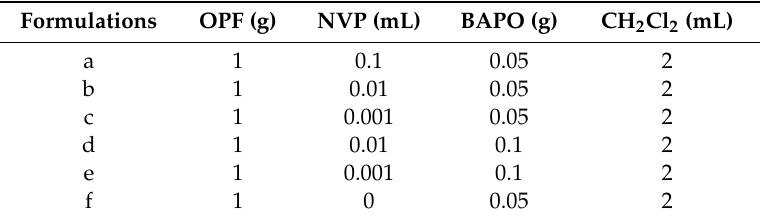
Table 1. Six different formulations implemented to make oligo[poly(ethylene glycol) fumarate] Table 1. Six di ff erent formulations implemented to make oligo[poly(ethylene glycol) fumarate] (OPF) (OPF) hollow cages. NVP: 1-Vinyl-2-pyrrolidinone. hollow cages. NVP: 1-Vinyl-2-pyrrolidinone.